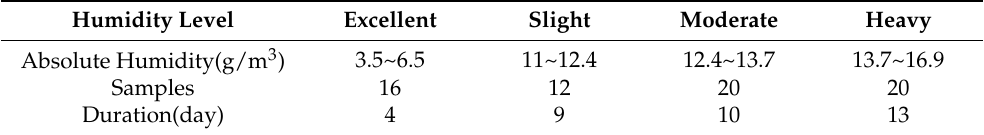
Table 1. The absolute humidity values, number of samples, and duration of CWW at different levels. Humidity Level Excellent Slight Moderate Heavy Absolute Humidity(g/m 3 ) 3.5~6.5